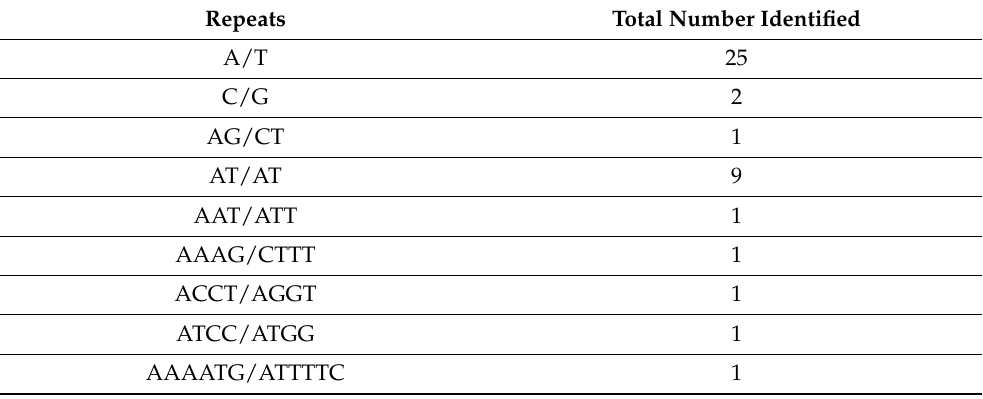
Table 3. Type of microsatellite repeat motifs identified in the chloroplast genome of Picea rubens